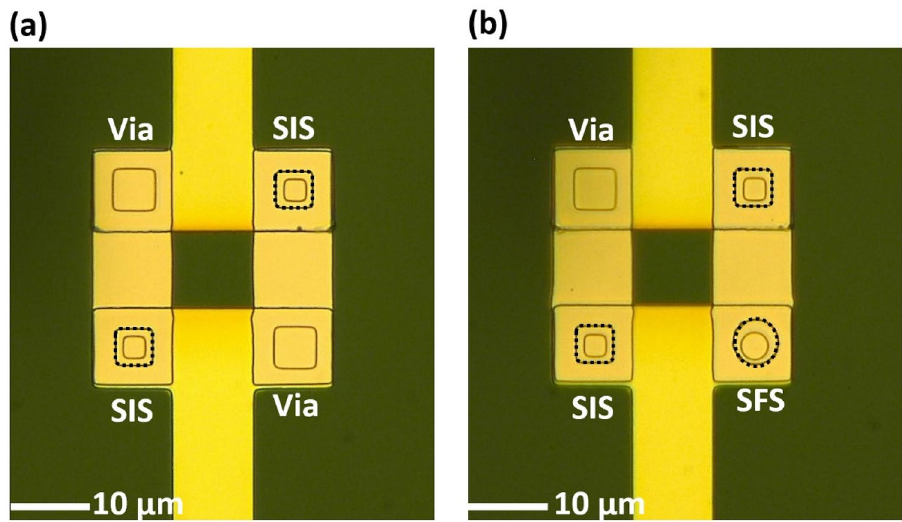
Figure 4. Microscope images of ( a ) a direct-current superconducting quantum interference device (dc-SQUID) and ( b ) a superconductor/ferromagnetic/superconductor (SFS)-SQUID with superconductor/insulator/ superconductor (SIS) and SFS junctions, as denoted by the dotted squares and circles, respectively.